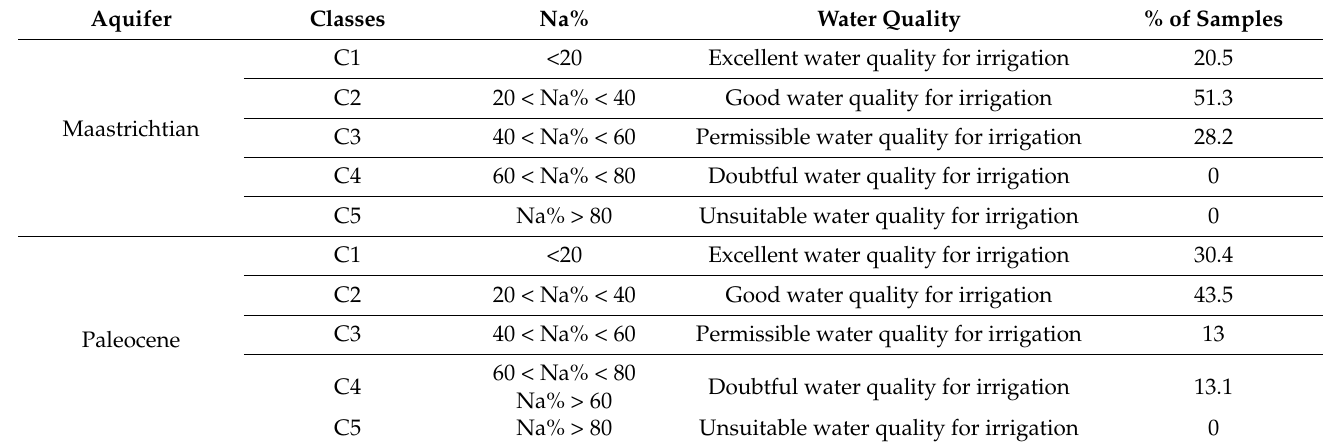
Table 5. Classification of the water samples according to the percentage of Na (Na%).